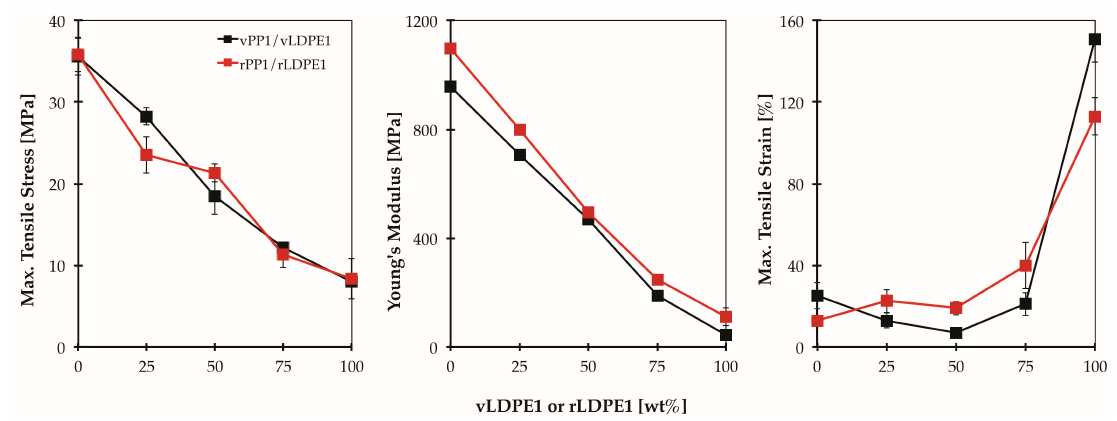
Figure 11. Tensile stress [MPa], Young’s modulus [MPa] and tensile strain [%] for vPP1/vLDPE1 and / rLDPE1 as a function of blend rPP1/rLDPE1 as a function of blend composition. rPP1